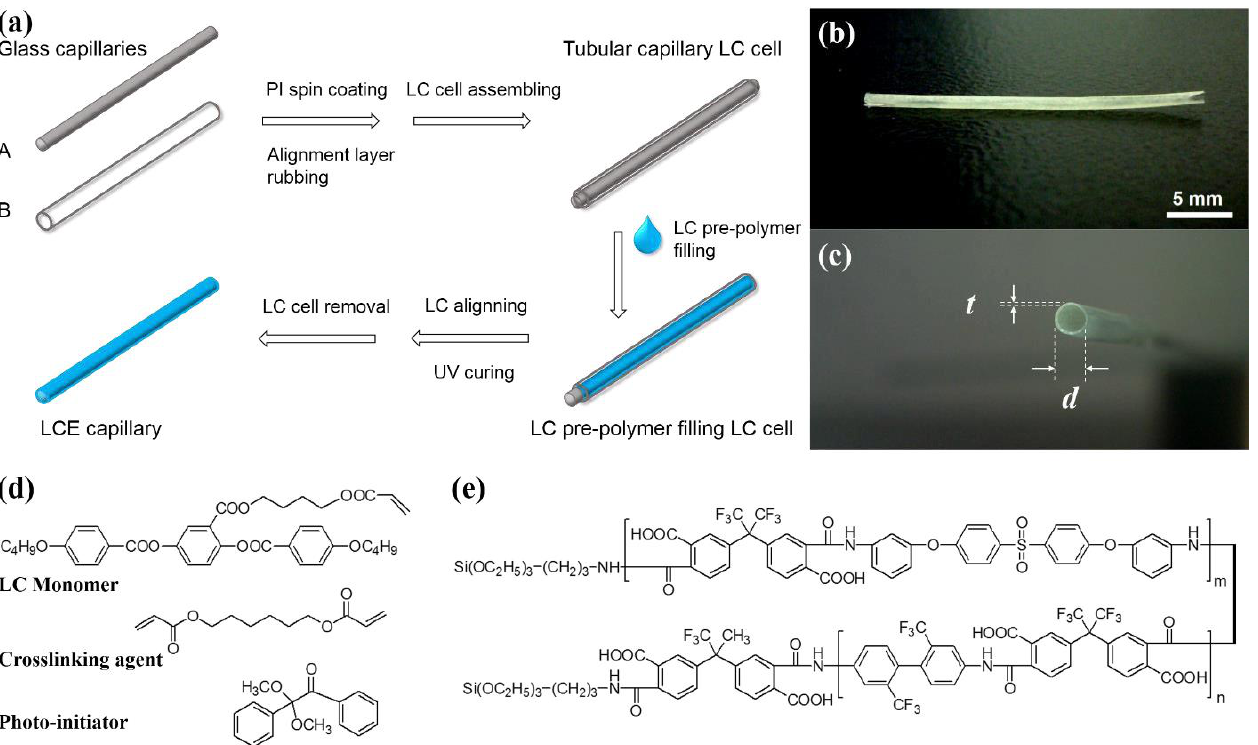
Figure 6. ( a ) Schematic view of LCE capillary fabrication via PI spin-coating, LC cell assembling, alignment layer rubbing, LCE precursor filling and photo-induced polymerization/crosslinking [43]. ( b , c ) photographic images of as-prepared LCE capillary with dimensions (Length = 27 mm, Diameter = 0.9 mm and wall thickness = 70 µm); ( d ) chemical structure of the monomer, crosslinking agent and photoinitiator; ( e )chemical structure of polyamic acidused for preparing polyimide alignment layer (Reprinted with permission from